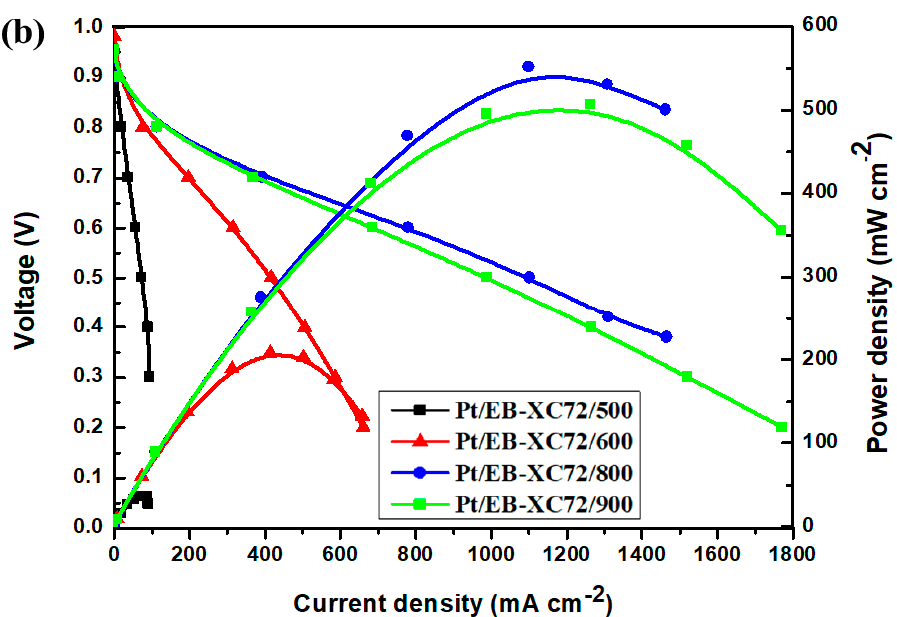
Figure 9. Electrocatalytic polarization and power density curve of a proton exchange membrane fuel cell (PEMFC) based on ( a ) Pt/XC72 and ( b ) Pt/EB-XC72 catalyst